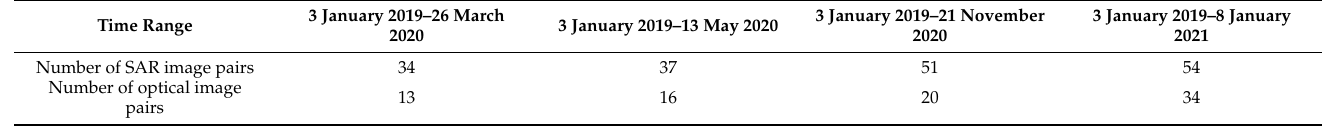
Table 3. Number of SAR and optical image pairs involved in the study of different periods.